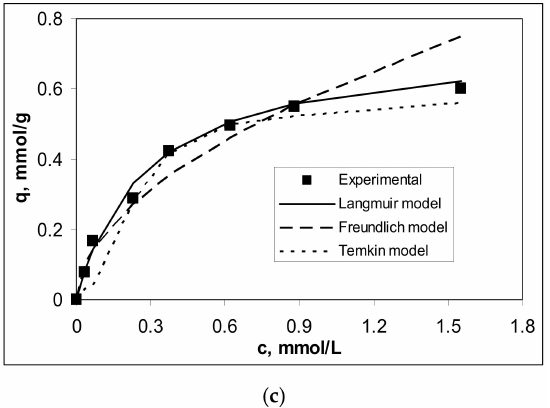
Figure 5. Experimental and theoretical isotherms obtained for the biosorption of ( a ) Cu(II), ( b ) Co(II) and ( c ) Zn(II) ions on Alg-Fe 3 O 4 -MPs. (Experimental conditions: pH = 5.4; adsorbent dosage = 2.0 g/L; contact time = 24 h; temperature = 23 ◦ C).